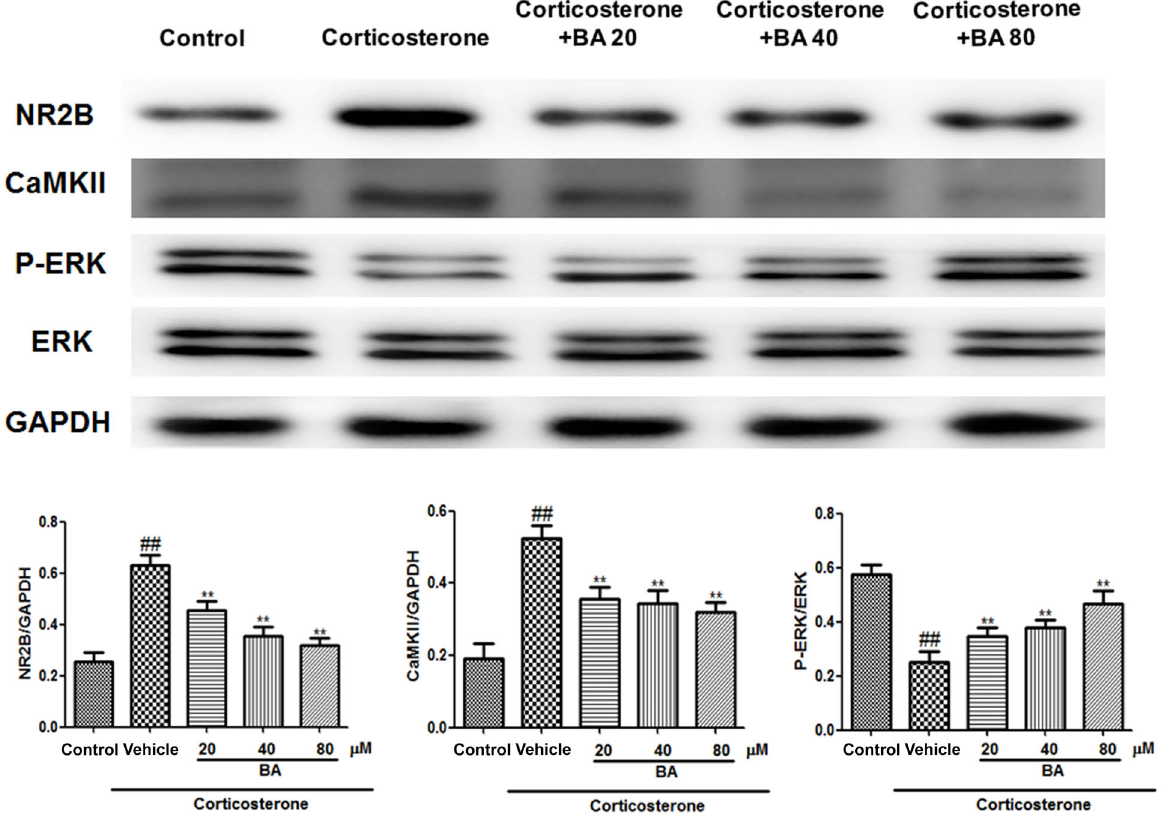
Figure 9. Effects of baicalin (BA) on NR2B, CaMKII, and P-ERK1/2 expression in PC12 cells. Data are reported as means ± SE (n=8). ## P o 0.01 vs control; **P o 0.01 vs vehicle